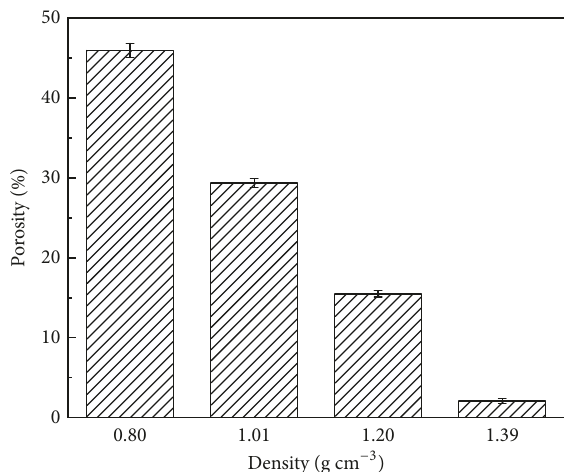
Figure 4: Porosity of scrimbers with varying densities.